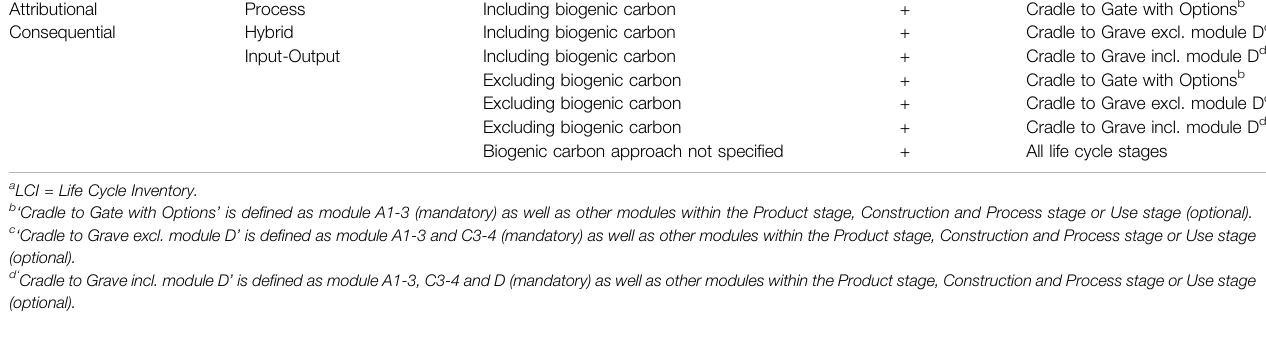
TABLE 3 | Meta data for fi nal sample of scenarios. World